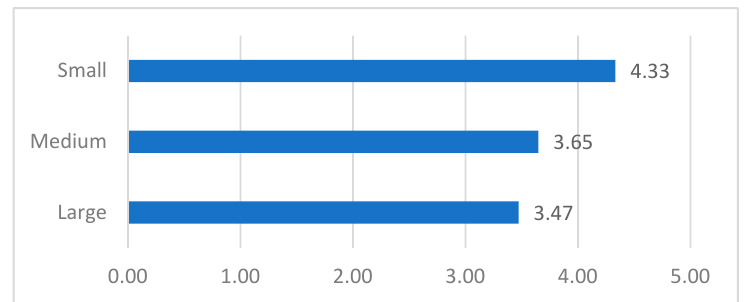
Figure 2. Evaluation of knowledge management quality in organizations by size.